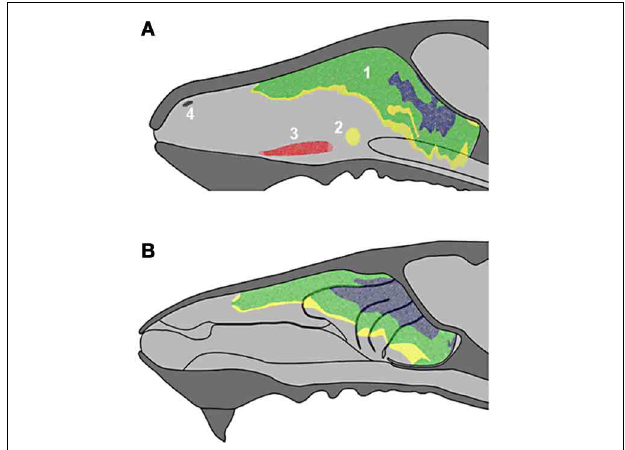
FIGURE 2 | Schematic drawings of the nasal septum (A) and the medial aspect of the nasal cavity (B), showing the locations of the main olfactory epithelium (1), septal organ (2), vomeronasal organ (3) and Grüneberg ganglion (4) with indication of epithelial thickness (yellow, thin; green, medium; blue, thick). See supplementary material.